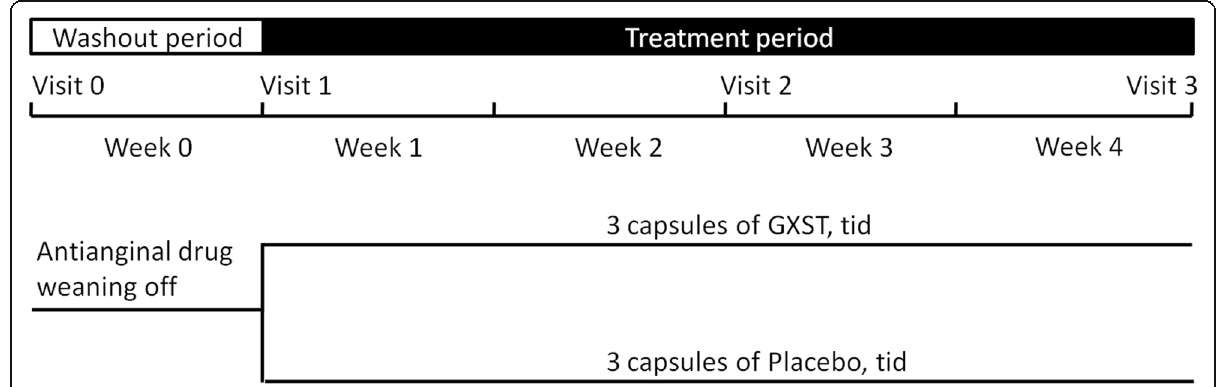
Fig. 1 Study program for each subject. GXST = guanxinshutong